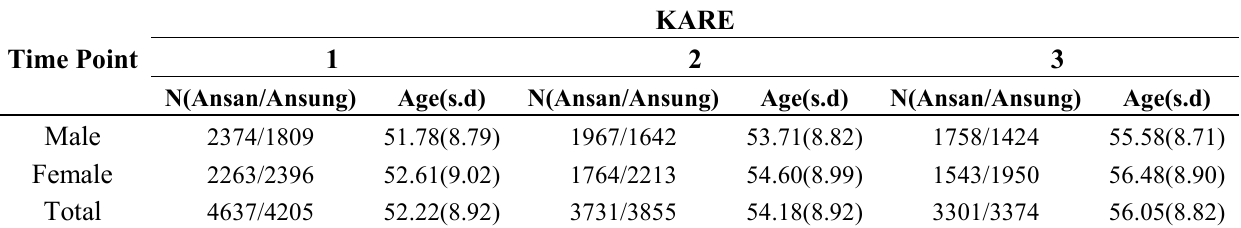
Table 1. Sample sizes for Korean Association Resource (KARE) cohort.